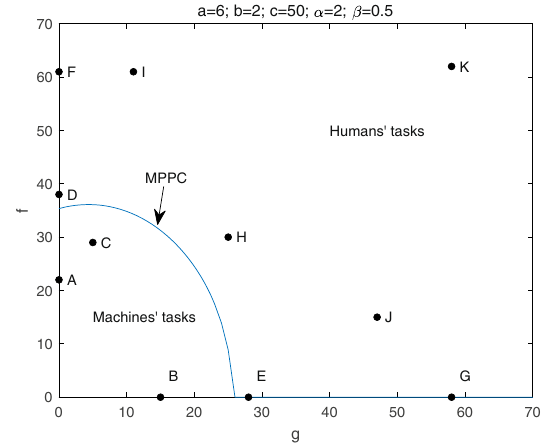
Fig. 1 Machine production possibility